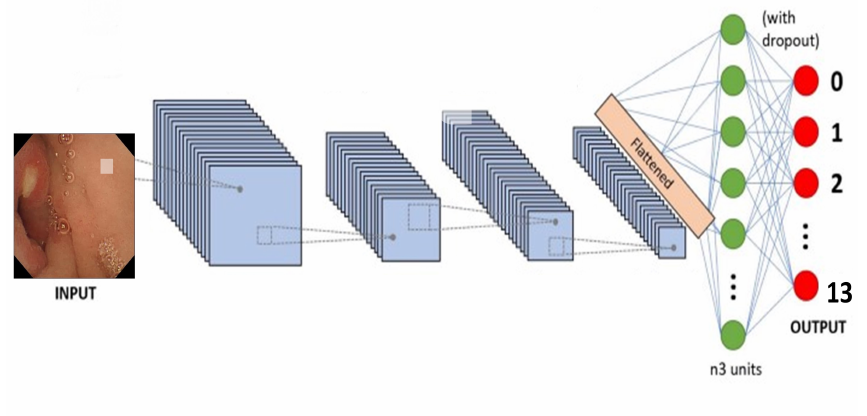
Figure 5. Generalized architecture of traditional CNN model.